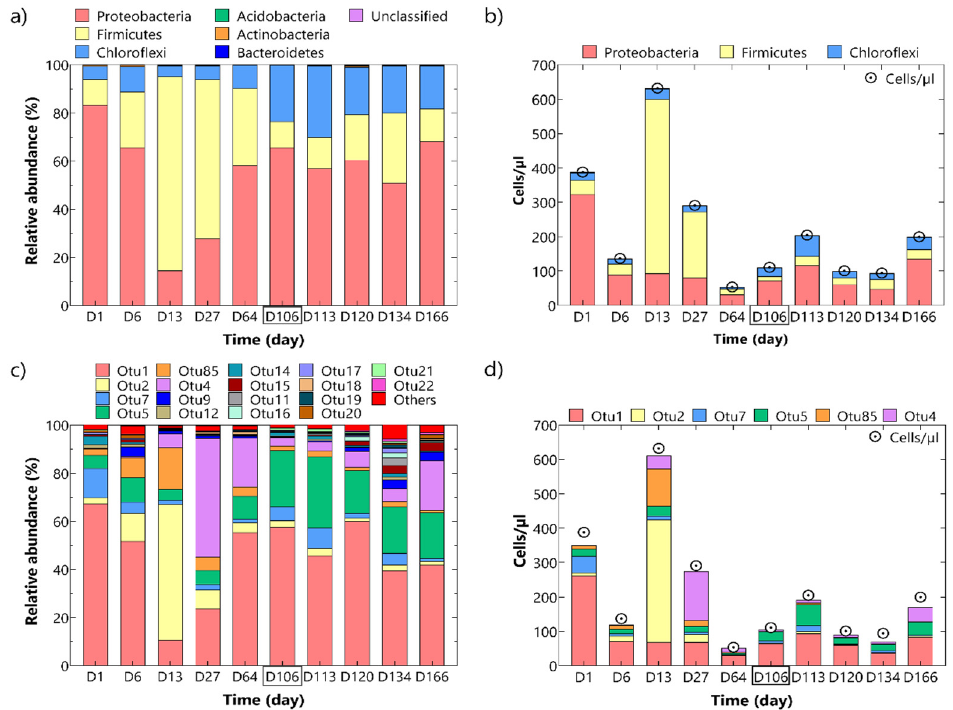
Figure 10. Relative ( a , c ) and absolute ( b , d ) abundance of the most dominant phyla ( a , b ), and OTUs ( c , d ) present in the borehole water after injection with 5 µM followed by an injection with 60 µM selenate. The time of the second injection is highlighted with a rectangle in the X axis (D106).